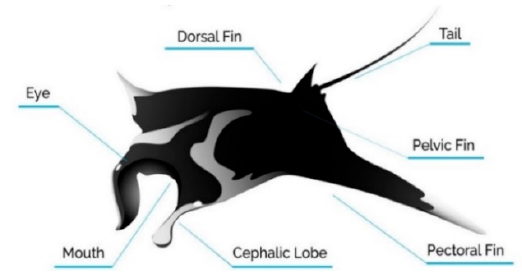
Figure 7. Anatomy of a manta ray. Electronics 2020 , 9 , x FOR PEER REVIEW 14 of 23